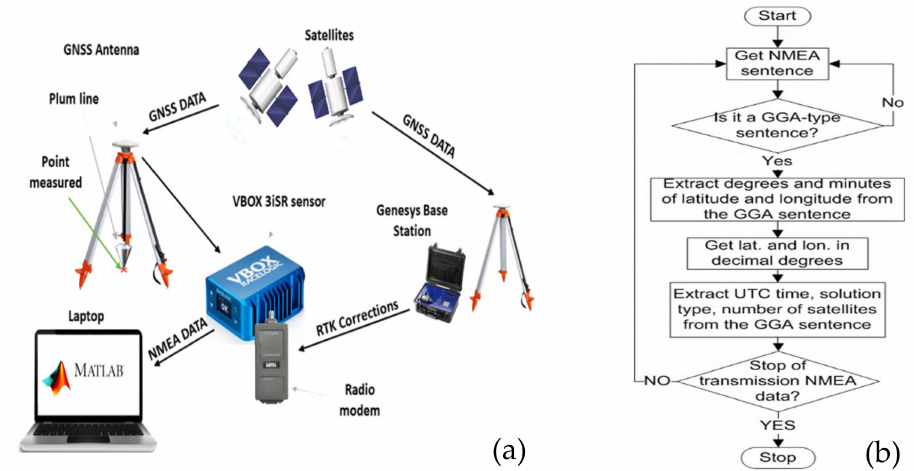
Figure 14. Experimental setup to detect the position of the measuring point by the VBOX 3iSR INS ( a ); flowchart of the developed Matlab code to process the NMEA data stream ( b